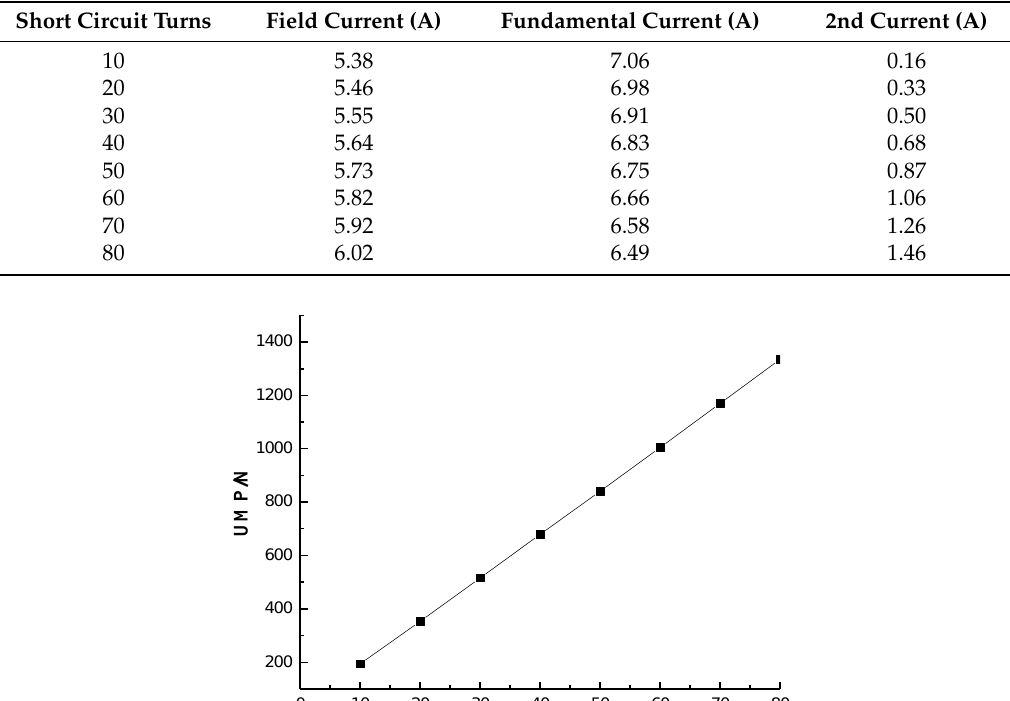
Table 5. UMP and the RMS of stator harmonic current when field concentric coils with different pitches undergo the same turn short circuit.